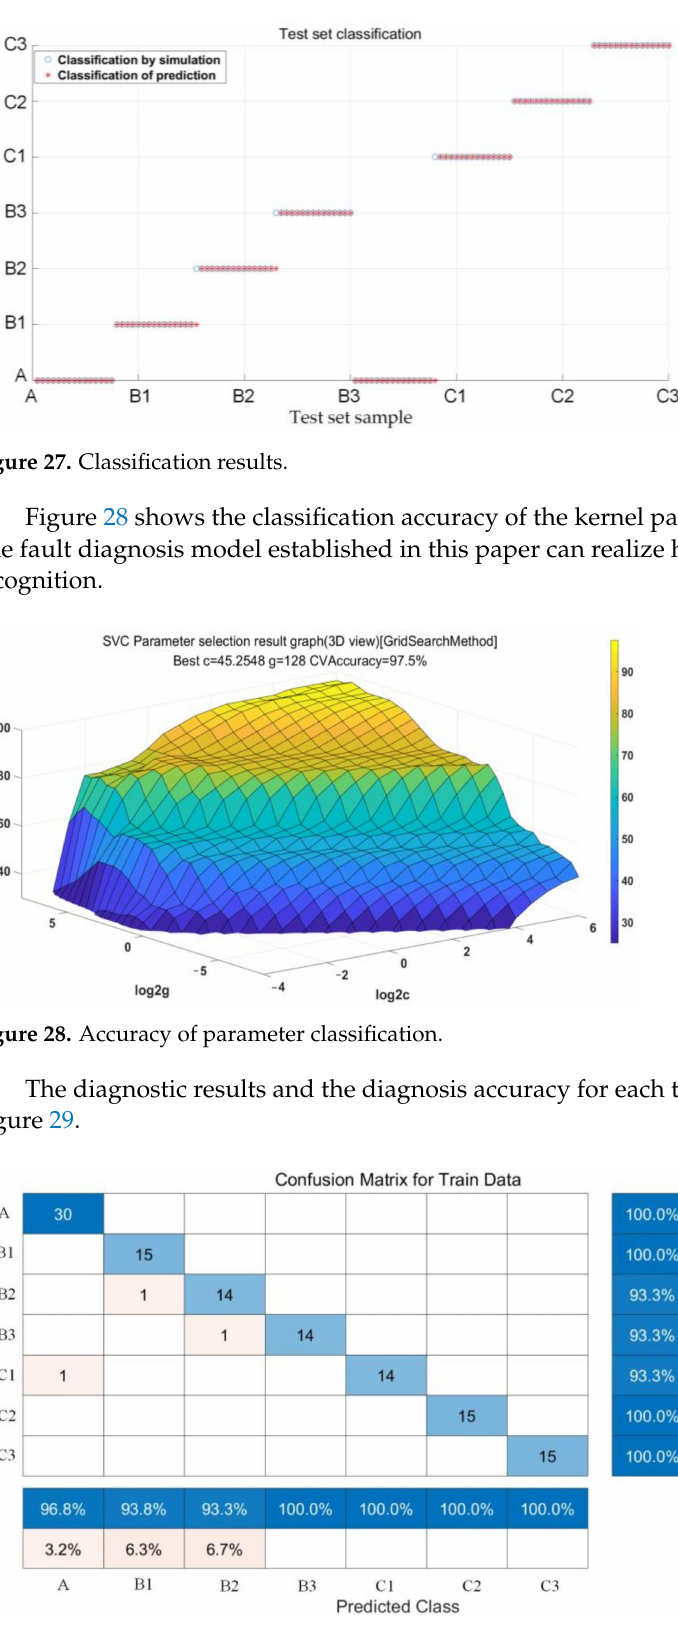
Figure 29. Distribution of diagnosis results. The accuracy of all fault modes is shown in Table